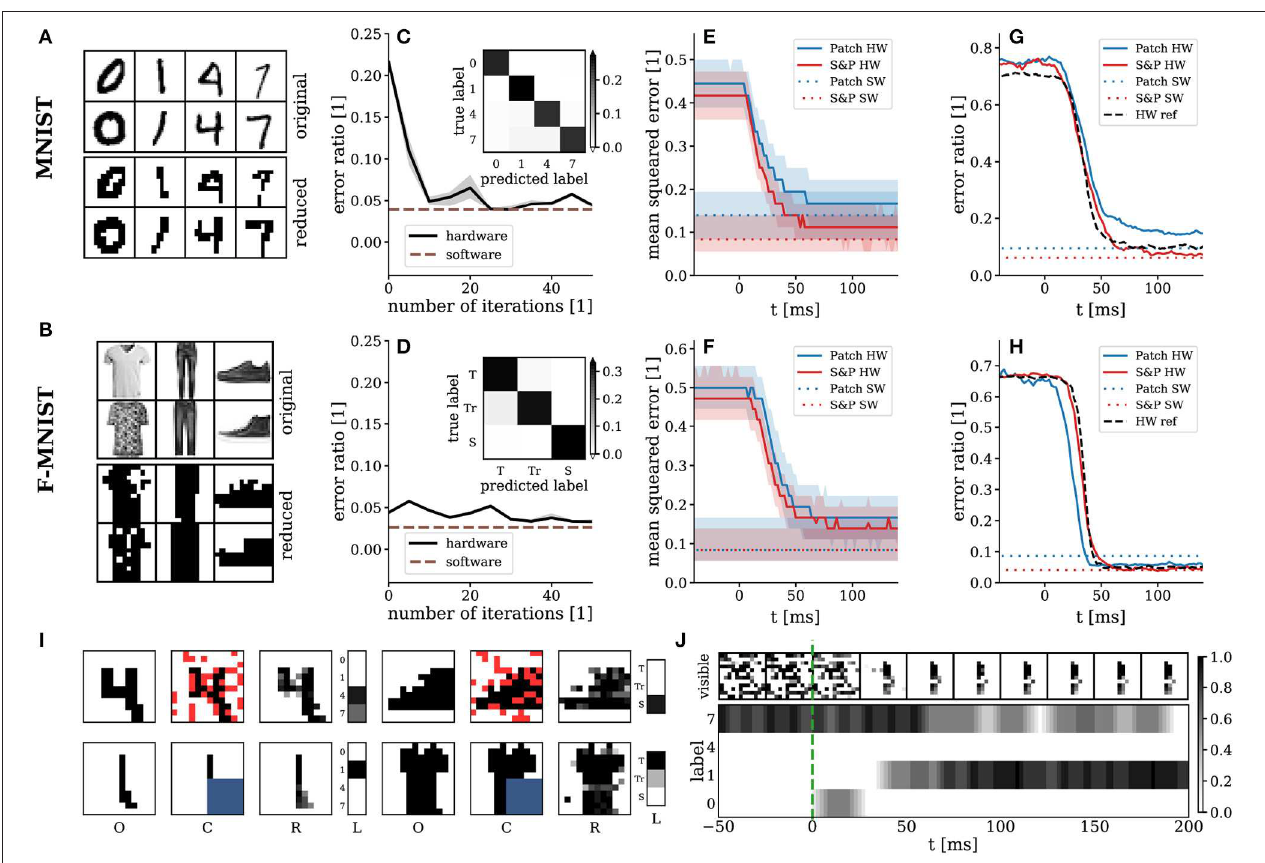
FIGURE 6 | Behavior of hierarchical SSNs trained on data. Top row: rMNIST; middle row: rFMNIST; bottom row: exemplary setups for the partial occlusion scenarios. (A,B) Exemplary images from the rMNIST (A) and rFMNIST (B) datasets used for training and comparison to their MNIST and FMNIST originals. (C,D) Training with the hardware in the loop after translation of pre-trained parameters. Confusion matrices after training shown as insets. Performance of the reference RBMs shown as dashed brown lines. Results are given as median and interquartile values over 10 test runs. (E,F) Pattern completion and (G,H) error ratio of the inferred label for partially occluded images (blue: patch; red: salt&pepper). Solid lines represent median values and shaded areas show interquartile ranges over 250 test images per class. Performance of the reference RBMs shown as dashed lines. As a reference, we also show the error ratio of the SNNs on unconcluded images in (G) and (H) . (I) Snapshots of the pattern completion experiments: O—original image, C—clamped image (red and blue pixels are occluded), R—response of the visible layer, L—response of the label layer. (J) Exemplary temporal evolution of a pattern completion experiment with patch occlusion. For better visualization of the activity in the visible layer in (I,J) , we smoothed out its discretized response to obtain grayscale pixel values, by convolving its state vector with a box filter of 10 ms